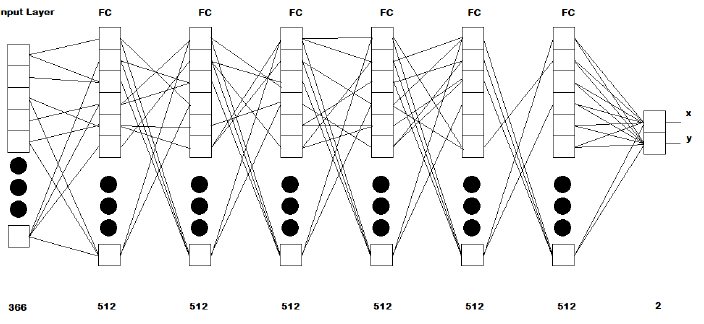
Figure 4. Architecture proposed for the methodological framework. The network consists of an input for 366 features, followed by 6 fully connected layers with 512 neurons each, and a final fully connected layer that outputs the gaze components (x and